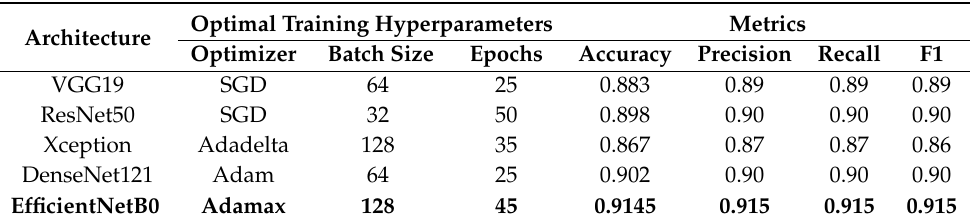
Table 4. Anatomic body site classification results for different neural network architectures with optimal set of parameters for each network and input images resized to 224 × 224.